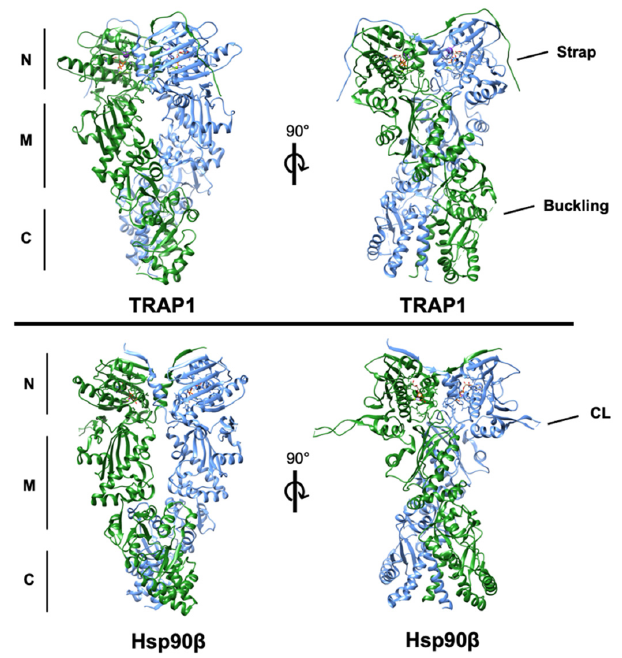
Figure 1. Structures of human TRAP1 (PDB: 6xg6) and human Hsp90 β (PDB: 5fwp) bound to nu- cleotide with the conserved N-, middle-, and C-domains denoted. One protomer of each is colored blue and the second is colored green. The regulatory N-terminal extension (strap) of each TRAP1 protomer can be observed overlapping the opposite protomer. The region of TRAP1 near the M-C boundary that ‘buckles’ during conformational rearrangement is incompletely resolved in the struc- ture. Additionally, the resolved residues of the charged linker domain (CL) of cytosolic Hsp90, which is absent in TRAP1, are labeled in the lower right quadrant. 3. Impact of TRAP1 on Cancer Metabolism Controversially, TRAP1 has alternately been characterized as an oncogene and tumor suppressor, and it has been suggested that TRAP1 is essential for malignant transfor- mation of cells but dispensable at later stages of tumor development [6,27]. Despite this controversy, much of the literature supports the idea that TRAP1 regulates metabolic transformation during tumorigenesis, TRAP1 is overexpressed in many cancers, and TRAP1 attenuation is detrimental to tumor cell survival [28–33]. It may be more appro- priate to suggest that, similar to cytosolic Hsp90, many cancers may be ‘addicted’ to TRAP1 [34–36]. In fact, multiple pathways in which TRAP1 activity can drive tumorigen- esis have been described () and will be reviewed in the following section.